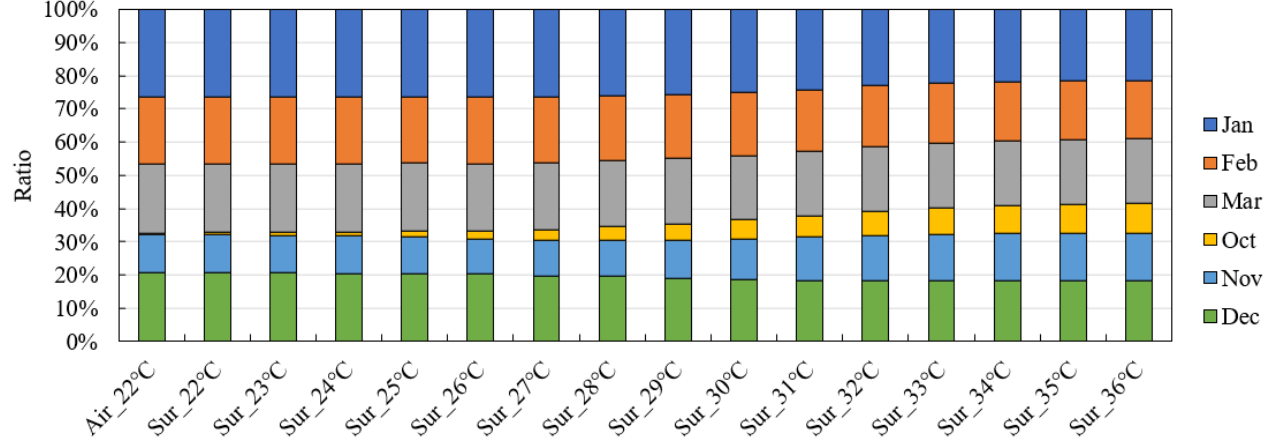
Figure 14. Ratio of monthly heating load to annual heating load.